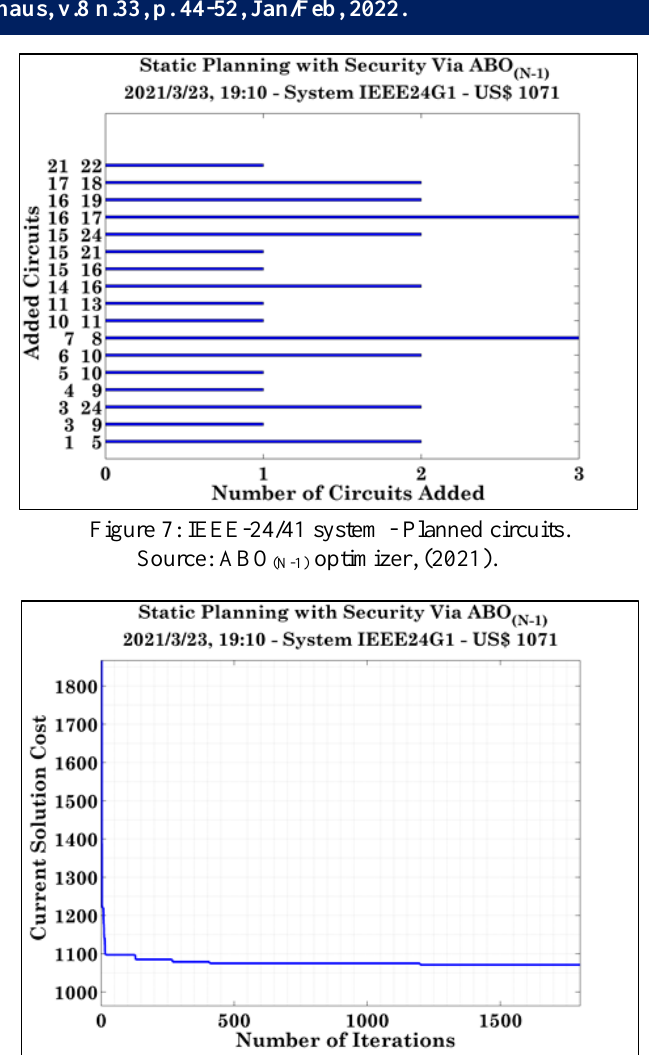
Figure 8: IEEE-24/41 system - Cost evolution of the best solution. Source: ABO (N-1) optimizer,